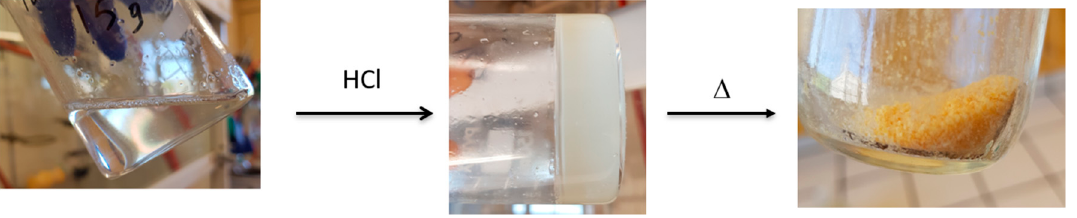
Figure 4. Sol–gel transformation of poly(VDF- ter -VTEOS- ter -VDMP) terpolymer ( P 20 ) in DMF catalyzed by HCl followed by solvent removal at 80 °C under 20 × 10 − 3 bar to produce a crosslinked polymer ( CP 20 ).